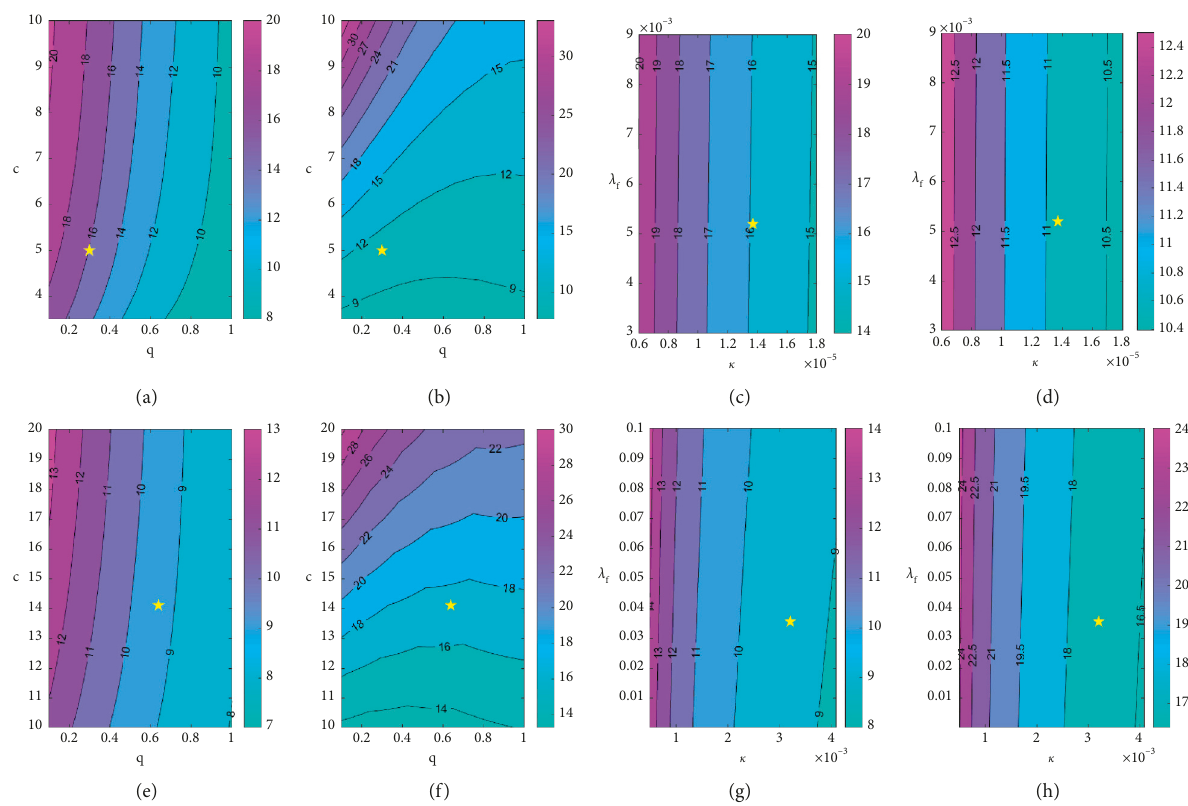
Figure 7: Contour plots of the peak time and peak size of the number of newly confirmed cases with respect to q and c from 20 January to 28 April (a, b) and from 11 June to 3 September, 2020 (e, f). Contour plots with respect to λ f and κ from 20 January to 28 April (c, d) and from 11 June to 3 September, 2020 (g, h). The yellow star represents the position of ( q,c ) or ( λ f , κ ) we have estimated using the data to fit the targeted model (1). (a) Peak time. (b) Peak size. (c) Peak time. (d) Peak size. (e) Peak time. (f) Peak size (g) Peak time. (h) Peak